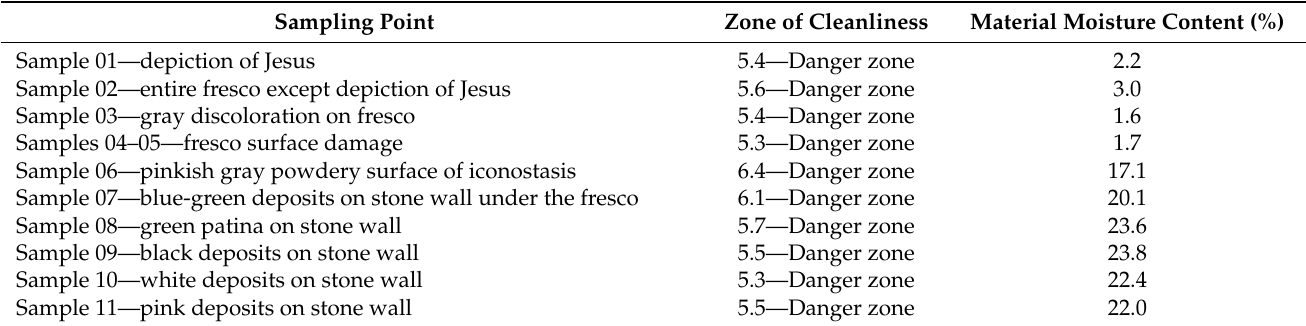
Table 1. Zone of cleanliness and material moisture content (%) values of various sampling points on cave walls, fresco, and iconostasis within Cave Church of Sts. Peter and